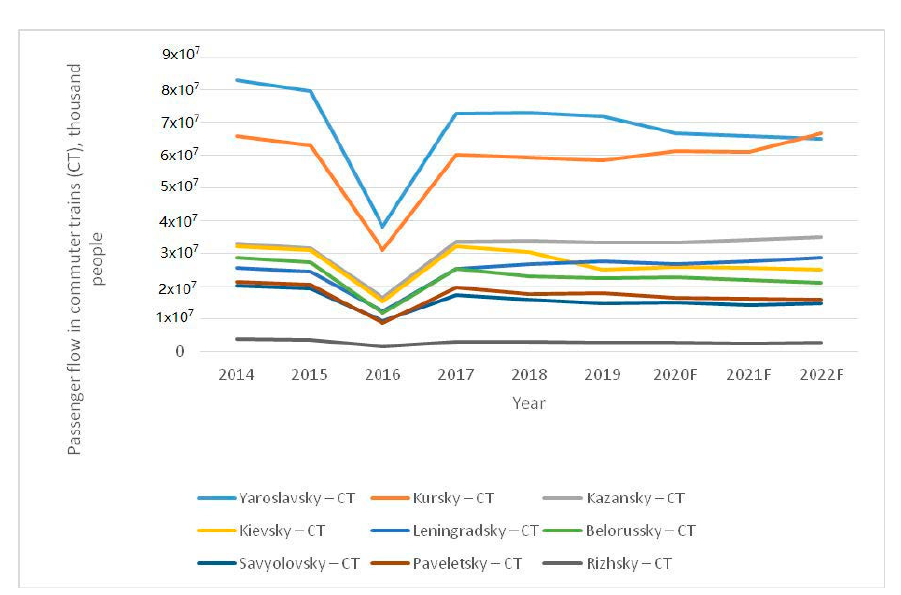
Figure 5. Passenger flow in long-distance trains (LDT) at Moscow rail stations and its forecast, people. Then, base indexes of annual growth were calculated based on the data of 2019 (Table 2). Table 2. Base indexes of annual growth of the passenger flow at rail stations (F — forecast). Rail Station